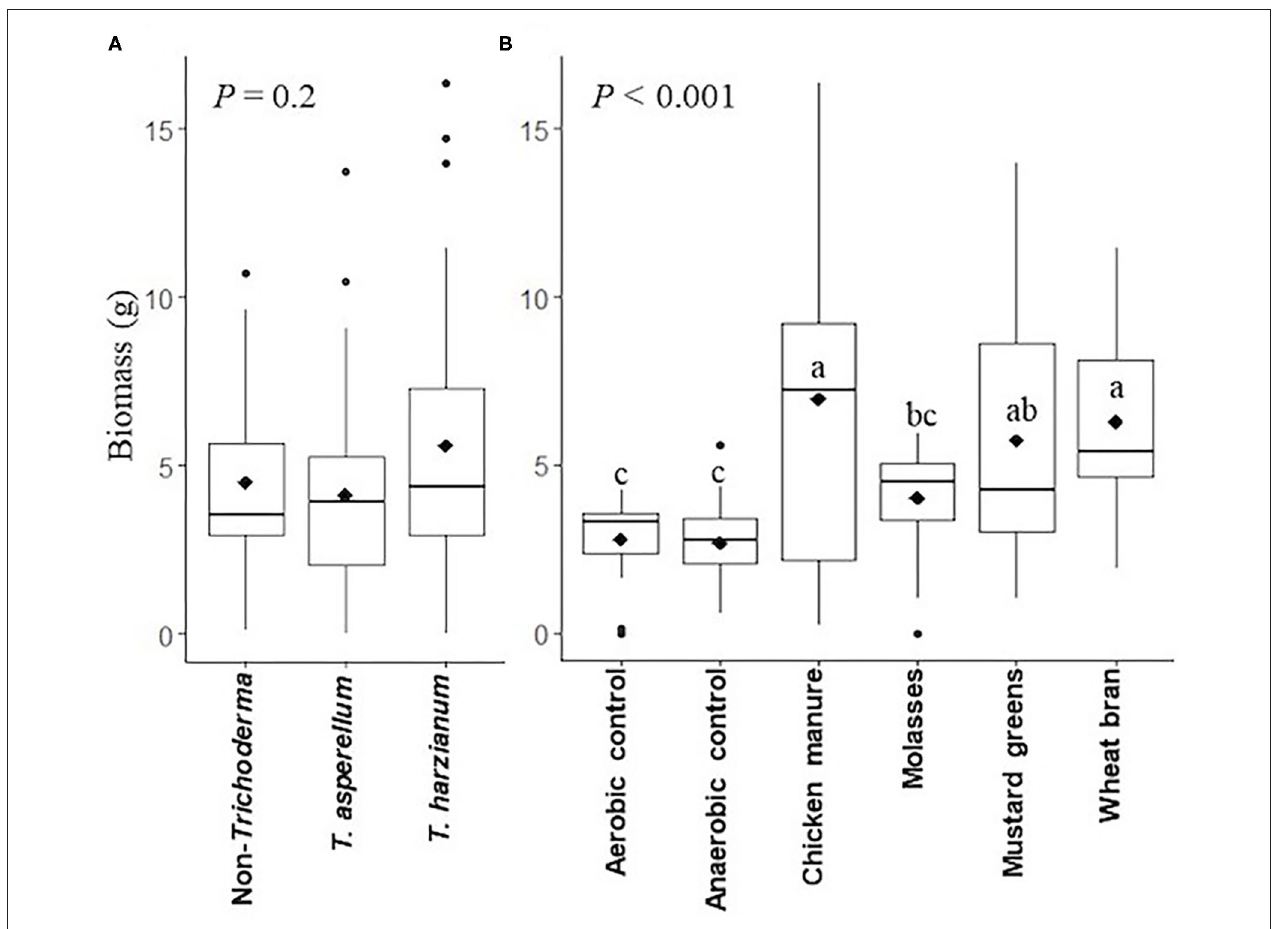
FIGURE 3 | Radish plant biomass (fresh weight) (A) as affected by Trichoderma isolate inoculation (main plots) and anaerobic soil disinfestation (ASD) carbon sources (subplots) (B) presented in box plots; black lines indicate median, black diamonds indicate mean values and black dots are outliers, P -value is the analysis of variance probability value. Means followed by same letter(s) do not differ significantly at 5% level of probability. Data presented are from two combined independent experiments each with three